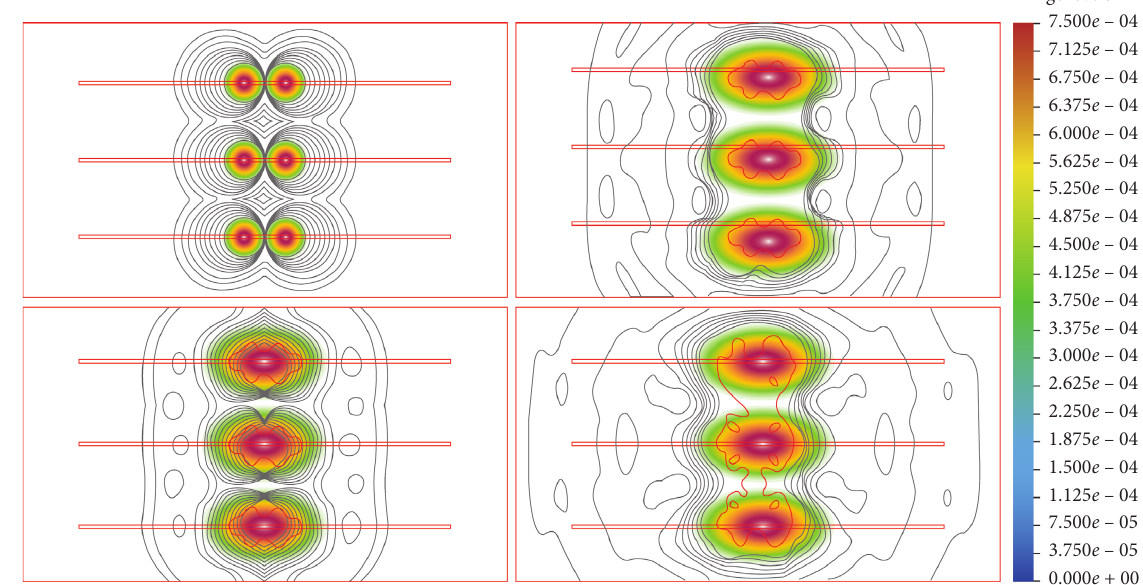
Figure 6: Contours of typical explosive effective stress at different stages after detonation.